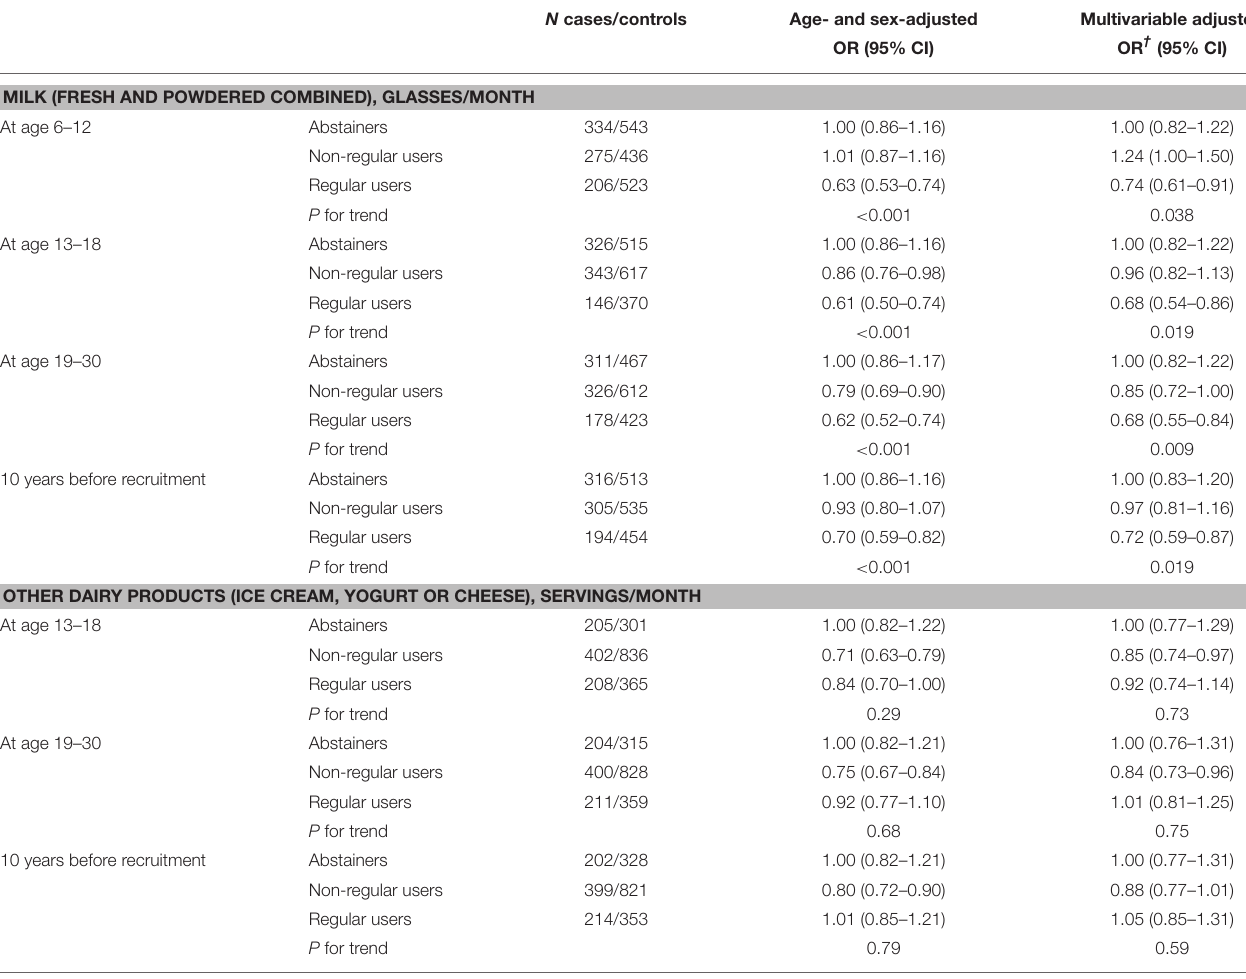
TABLE 2 | Odds ratios (ORs) and 95% confidence intervals (CI) of nasopharyngeal carcinoma for dairy product consumption in 815 NPC cases and 1,502 controls after multiple imputation = 1 .